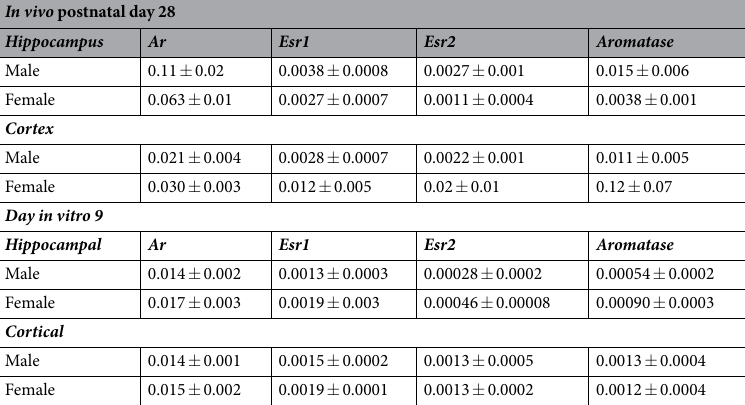
portions of the dendrite. In cortical cultures, more subtle sex differences are observed with female cortical neu- rons exhibiting fewer but longer primary dendrites relative to male cortical neurons. In the developing mouse hippocampus, robust sex differences in dendritogenesis were observed in vivo and in vitro , and in both models, male neurons elaborate more complex dendritic arbors than female neurons. While